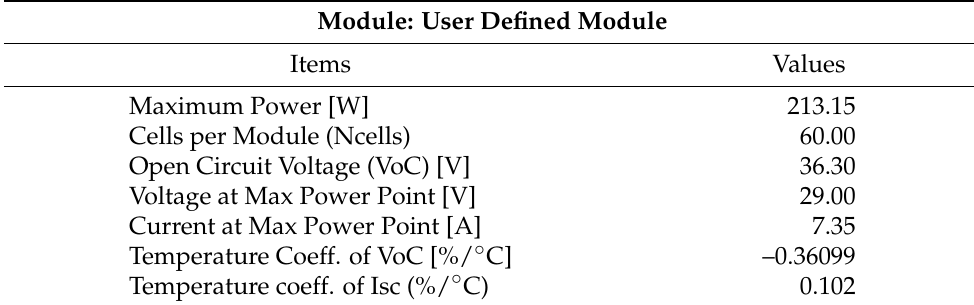
Table 3. Illustration of a user defined module parameters in